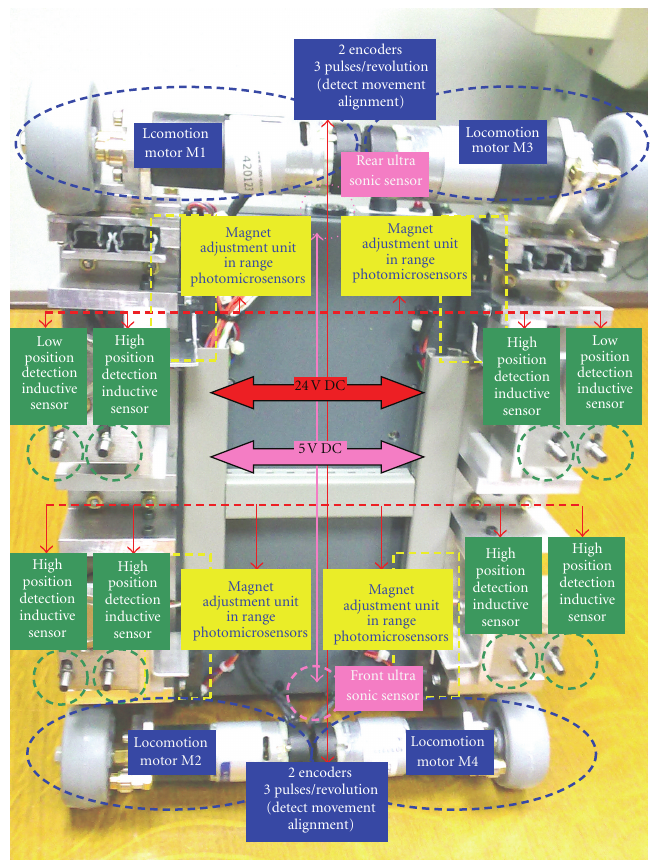
Figure 10: View from lower plane of the climbing